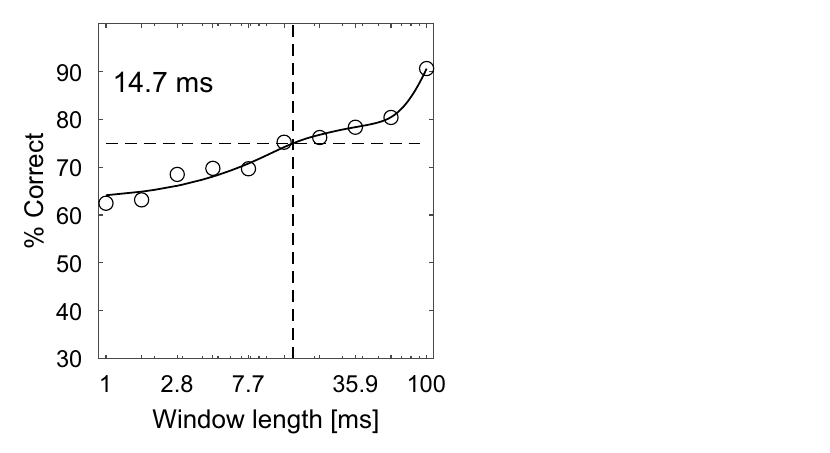
Figure 7. Cortical discrimination performance in response to phase-randomized aggression calls. Each circle marks the population discrimination performance of the 21 cortical units that showed a significant decrease in their firing rate when presented with increasingly phase-randomized aggression calls. The resulting function yields a threshold window-length of 14.7 ms (vertical dashed line). The horizontal dashed line at 75% depicts significance level (20 trials, binomial test, p <